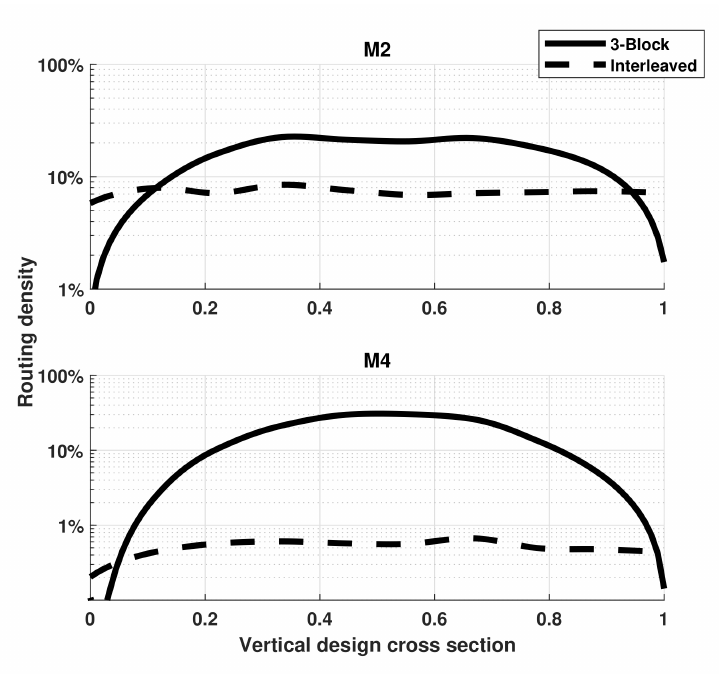
Figure 7. Vertical cross section of metal routing density for M2 and M4 vertical routing